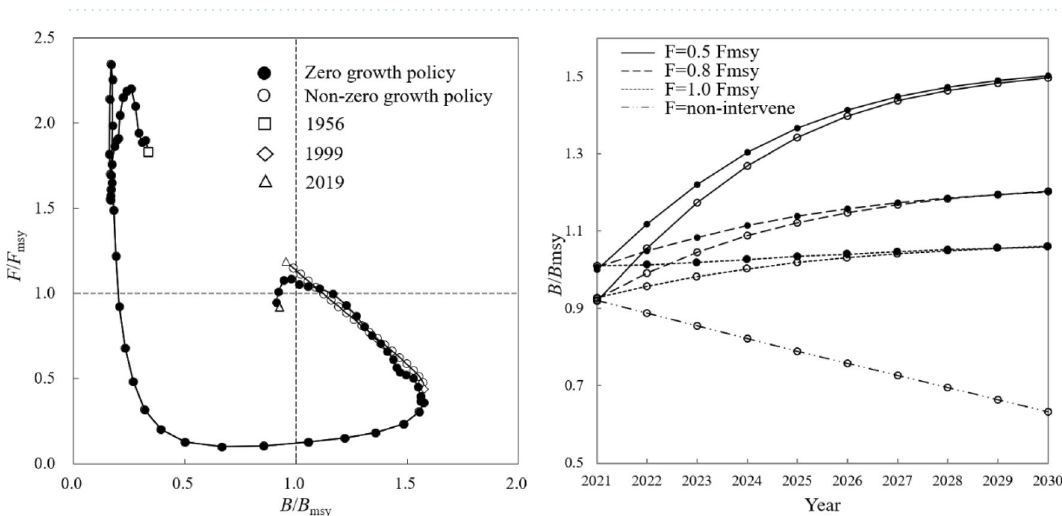
Figure 7. Rebuilding status of Larimichthys polyactis . Resource status in different quadrants following explanation in Fig.